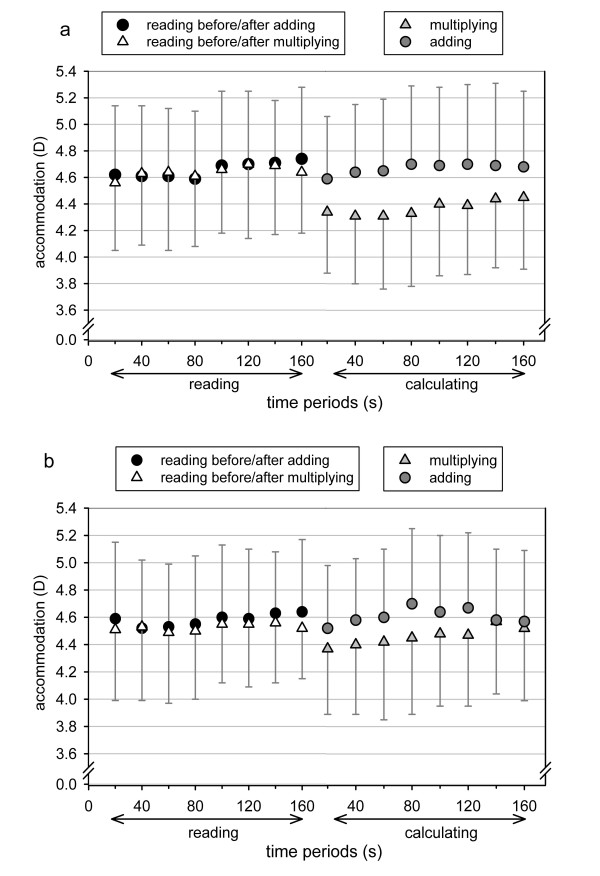
Accommodation results of experiment 3. Accommodation (D) as function of experimental phase (reading or calculating) and calculation content (adding or multiplying). a. shows accommodation data for all 20 subjects regardless of the correctness of task processing while b. shows the accommodation data of 16 subjects collected only during correct task processing. (Note that in b the remaining difference in accommodation between multiplying and reading/adding is mostly due to gaze drifts, which were accounted for statistically BUT not graphically.)